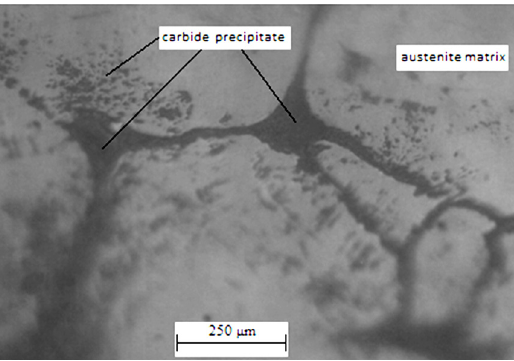
Figure 11. Optical micrograph of sample of failed crusher jaw (F ). The microstructure shows large carbides, which are mainly 4 at austenite grain boundaries and sparsely in the austenite matrix.